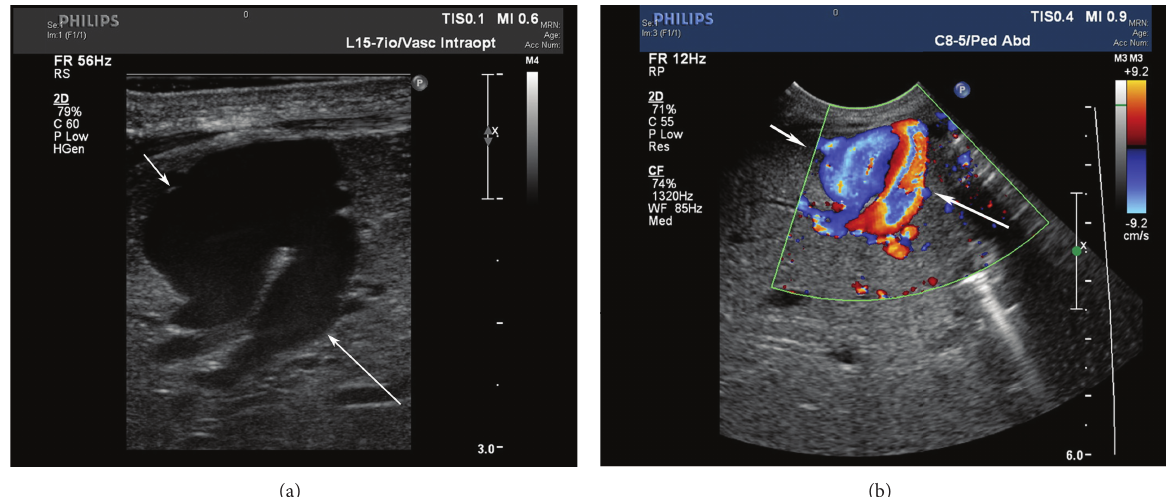
Figure 1: (a) Gray-scale ultrasound of the fistulous communication between the left portal vein (long arrow) and left hepatic vein (short arrow). (b) Color Doppler ultrasound image of the junctional fistulous communication point demonstrating inflow in the left portal vein (long arrow) and outflow in the left hepatic vein (short arrow).